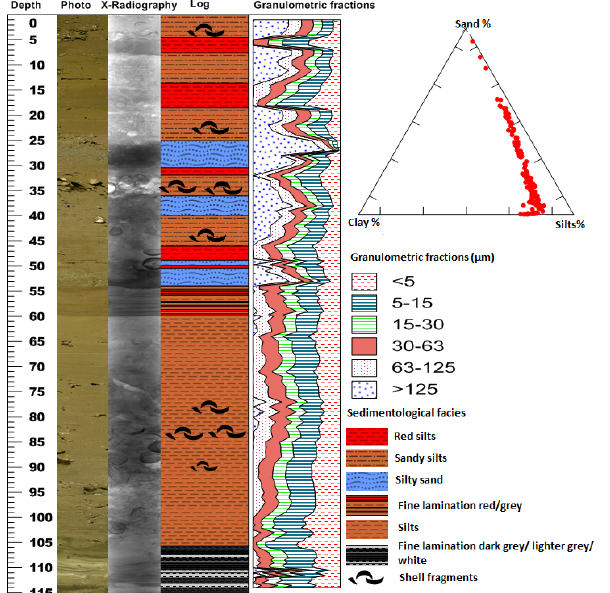
Figure 2. Photography, digital X-ray radiography, stratigraphic log and grain size results of MC45 core.